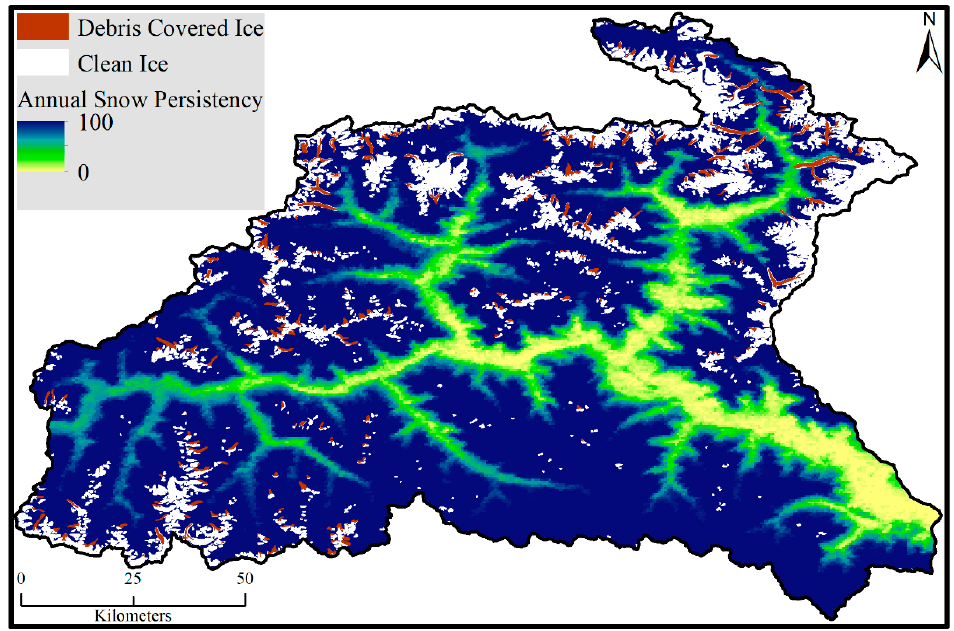
Figure 5. Annual snow persistency in (%) and glacier cover divided into debris-covered and clean-ice fraction. clean-ice